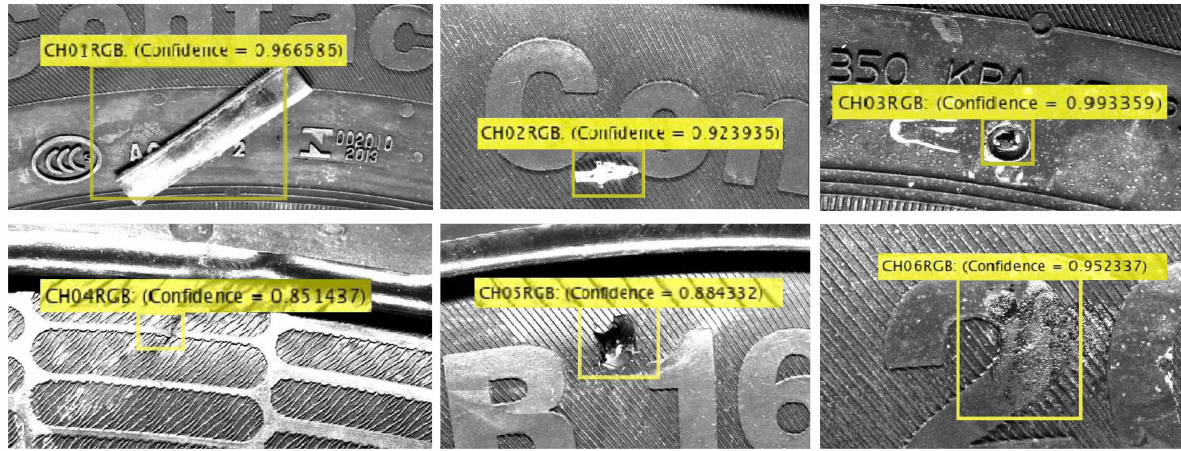
Figure 14. Samples of successful defect